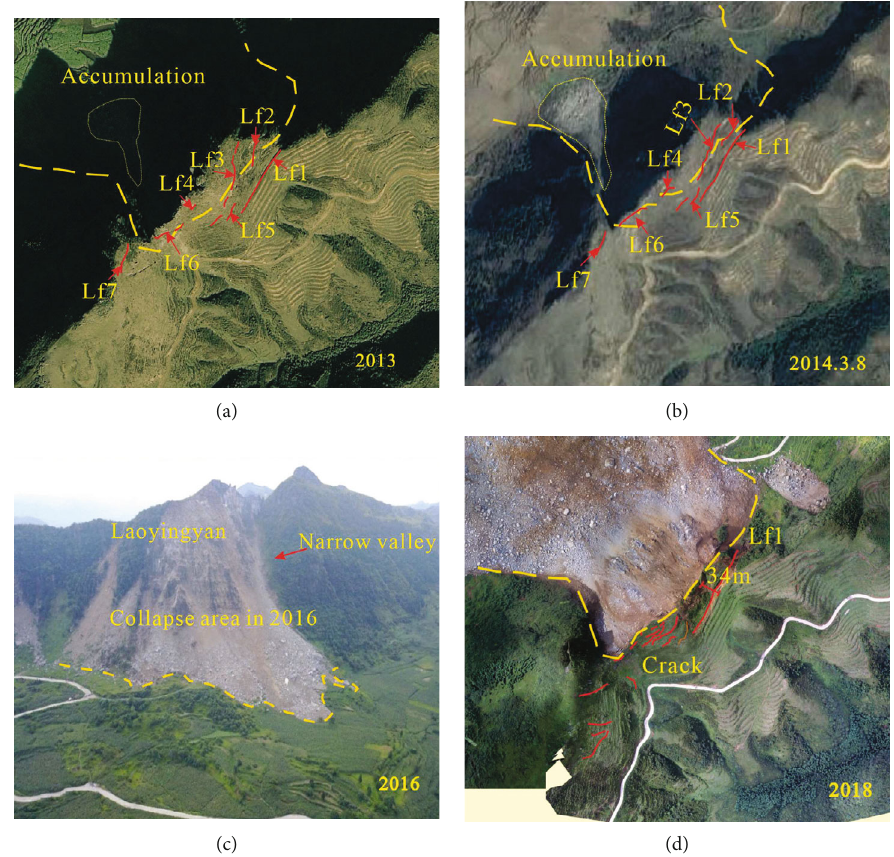
Figure 4: Images of the source area showing the cracks. (a) UAV image, 2013; (b) UAV image, August 2018; (c) front view, July 2016; and (d) UAV image, August 2018. Note: UAV refers to unmanned aerial